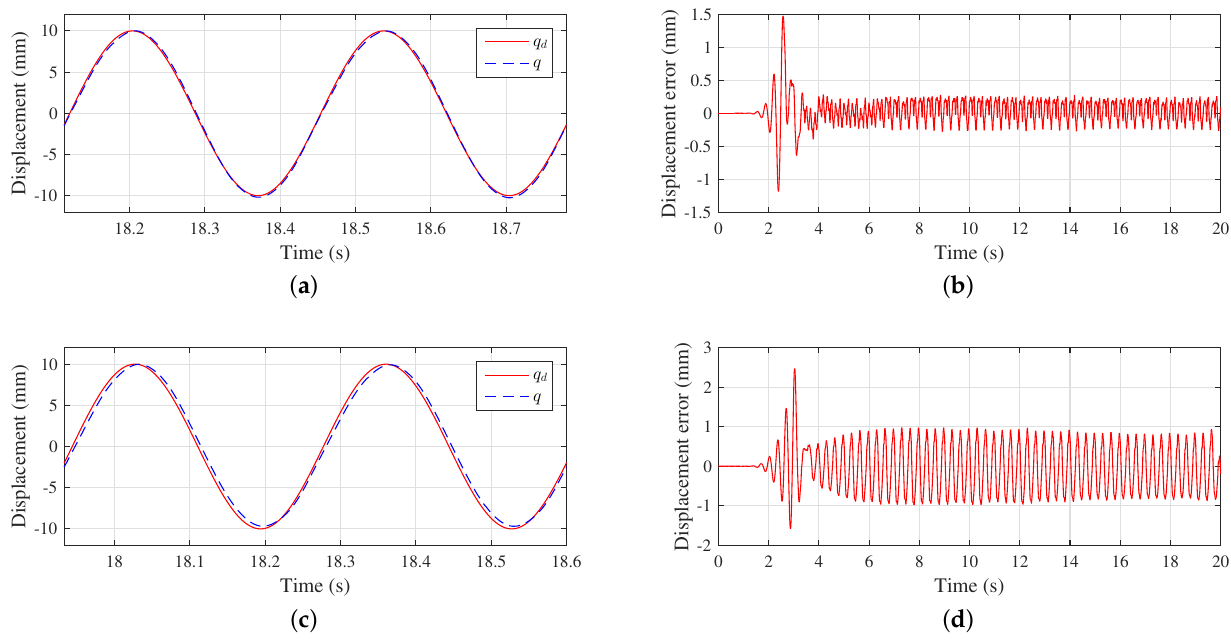
Figure 6. Comparison results at 3 Hz. ( a ) Trajectory tracking of σ -CAC; ( b ) position error of σ -CAC; ( c ) trajectory tracking of TAC; ( d ) position error of traditional adaptive control